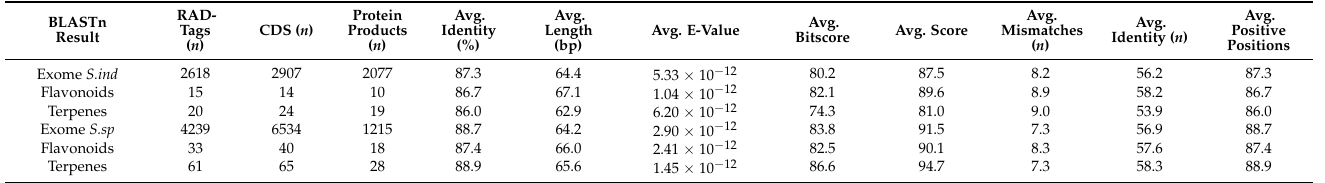
Table 4. Summary statistics of the BLASTN analysis of the RAD-Seq reads against the exomes of S. indicum and S. splendens . Statistics information of the flavonoids and terpenes pathways involved genes is also